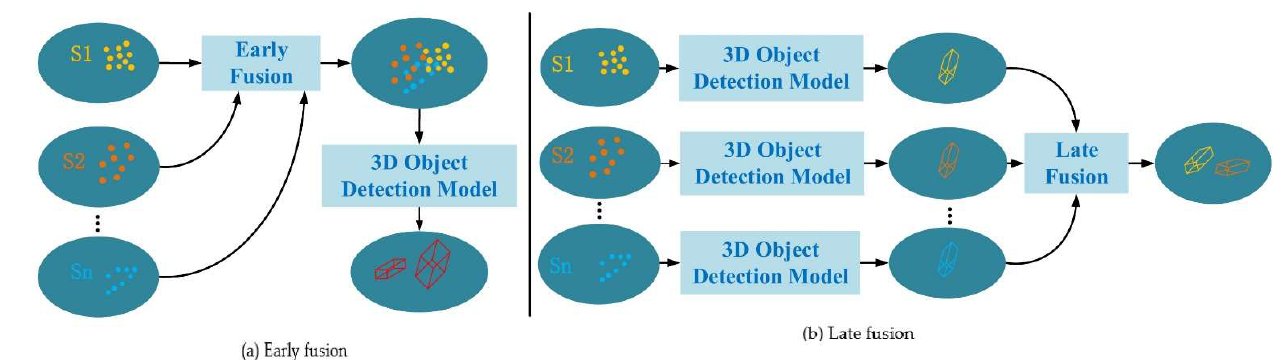
Figure 4. Early and late fusion schemes for cooperative 3D object detection.